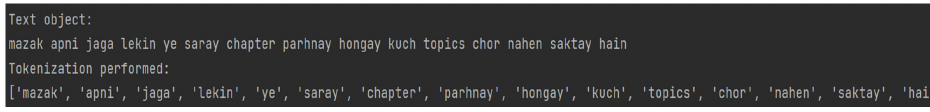
Figure 3. Tokenization of Roman Urdu